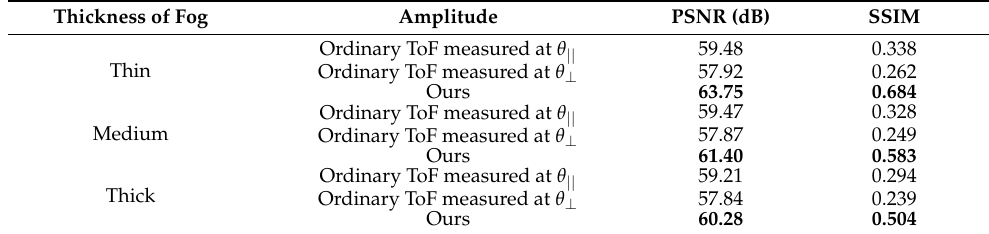
Figure 9. Experimental results in different thicknesses of fog. ( a ) The image captured by an ordinary ToF camera at θ || . ( b ) The image captured by an ordinary ToF camera at θ ⊥ . ( c ) The image recovered by our method. ( d ) The ground truth captured without fog. Table 1. Quantitative evaluation of the amplitudes using PSNR and SSIM.